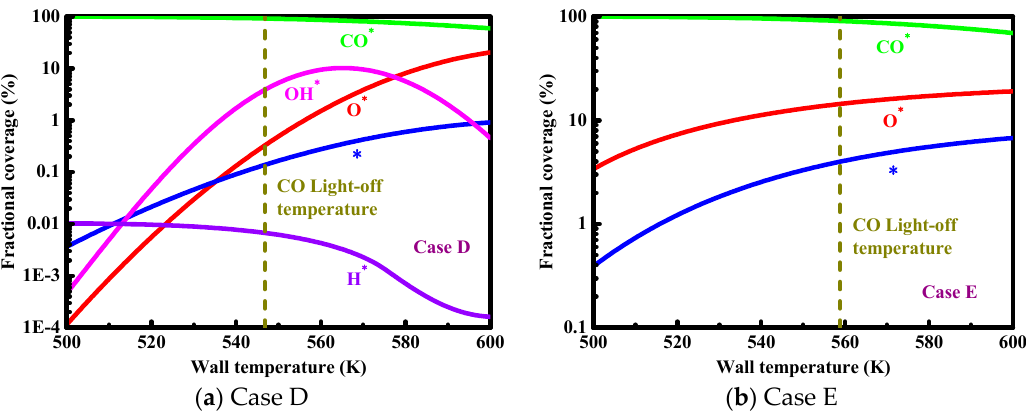
Figure 11. Fractional coverage of major surface species as a function of wall temperature for Cases D and E shown in Table 2. Case D represents syngas mixtures with hydrogen, whereas Case E represents syngas mixtures without hydrogen.